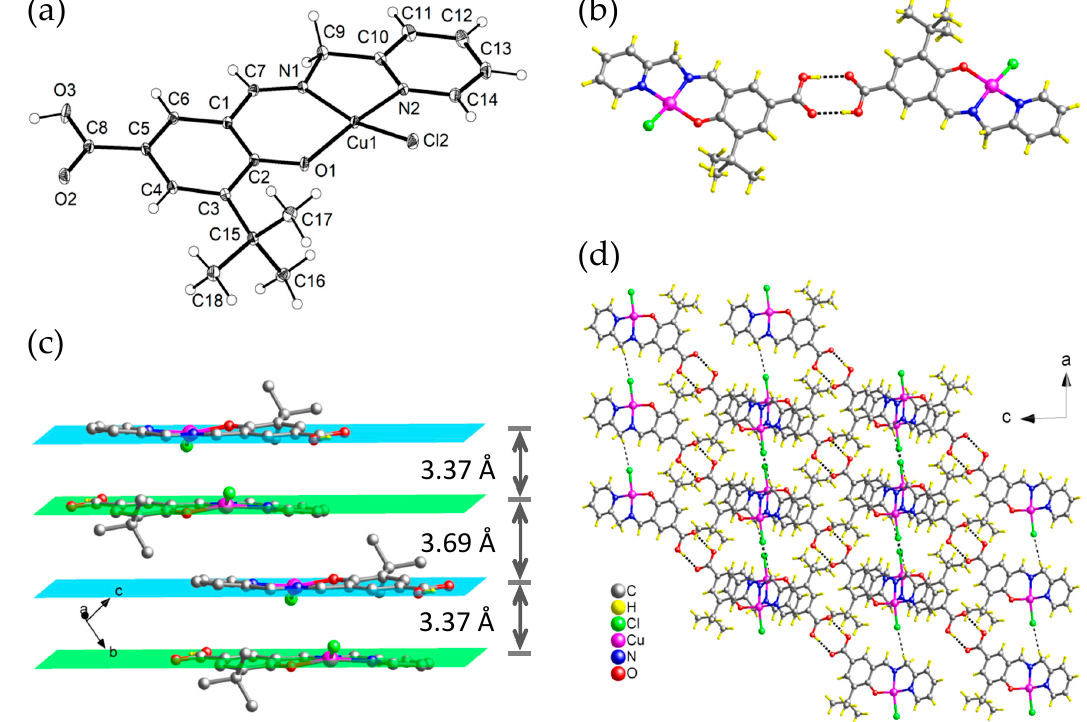
Figure 1. ( a ) ORTEP plot of 1 (30% probability ellipsoid) ( b ) A hydrogen-bonded dimer of [Cu(HL salpyca )Cl] generated from the R 2 2 (8) hydrogen-bonding pattern. ( c ) Representation of intermolecular π ··· π interactions (plane ··· plane: 3.37 and 3.69 Å) between any two neighboring [Cu(HL salpyca )Cl] molecules in 1 . ( d ) Packing diagram of 1 , showing O carboxyl –H ··· O carboxyl and C–H ··· Cl hydrogen-bonding interactions (dashed lines).